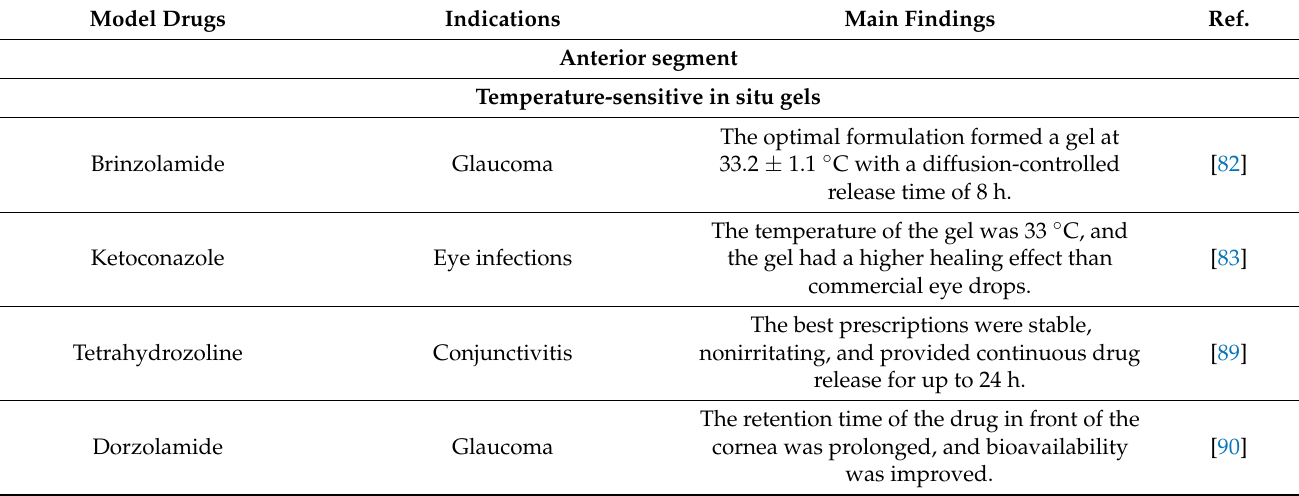
Table 3. In situ gel eye drop delivery systems in the application of the anterior and posterior segments of the